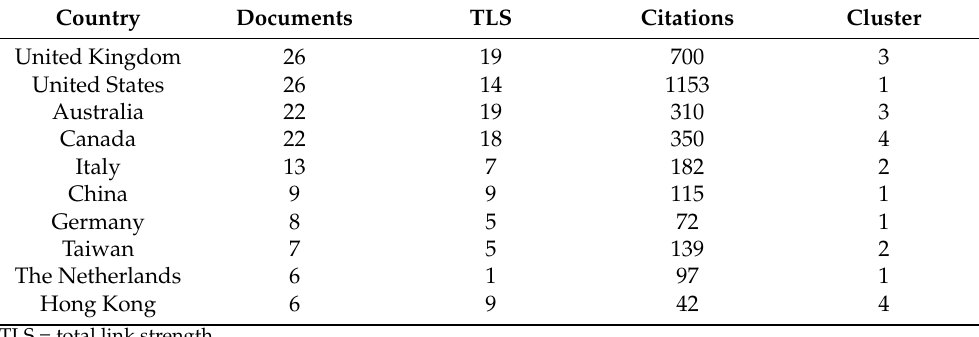
TLS = total link strength.